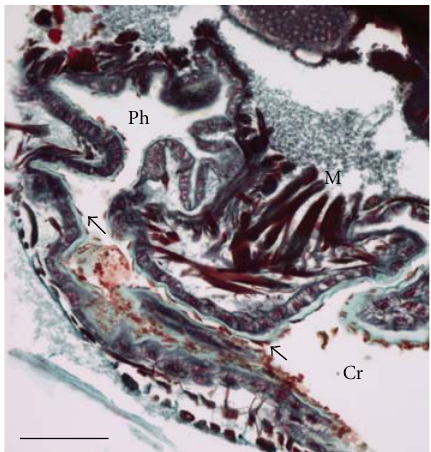
Figure 6: Muscular (M) pharynx (Ph) and anterior crop (Cr) of a N. abietis larva. Cuticular spines of the pharynx (arrows) are directed posteriorly. Scale bar = 0.1mm.